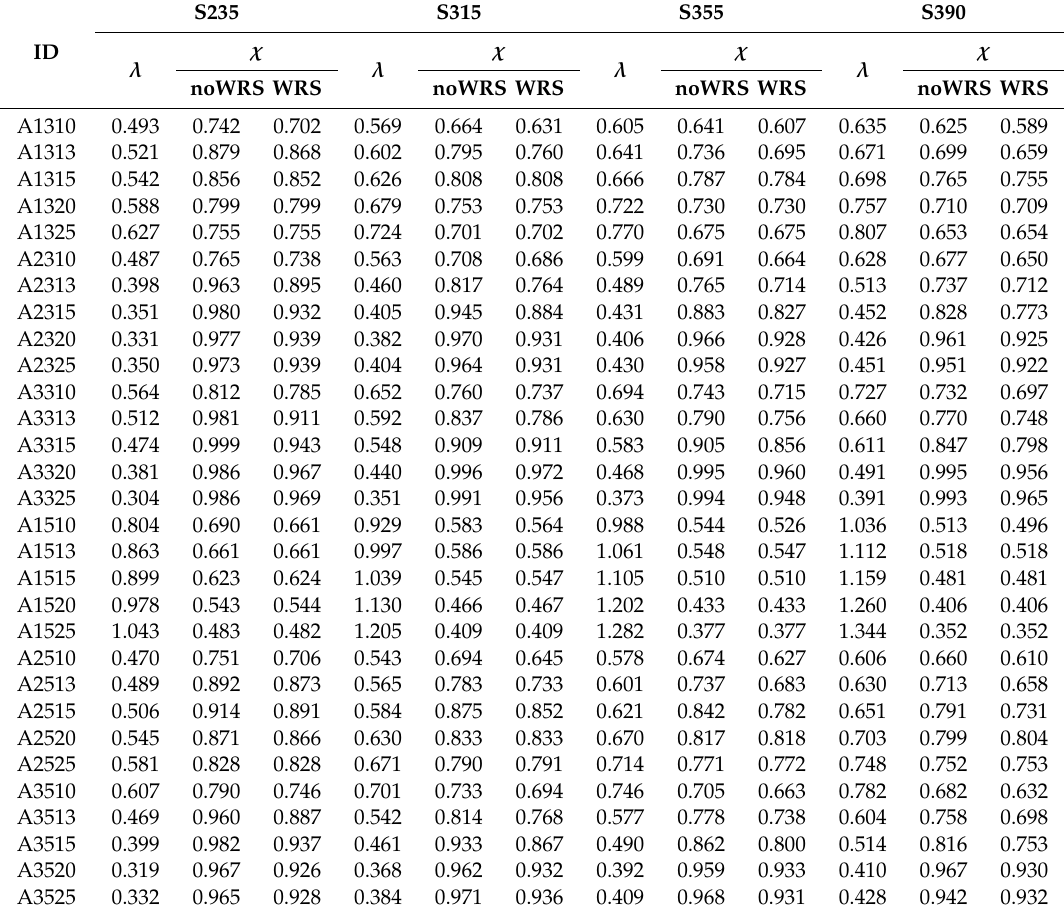
Table A5. Ultimate strength of angle-bar sti ff ened plates made of various steels.